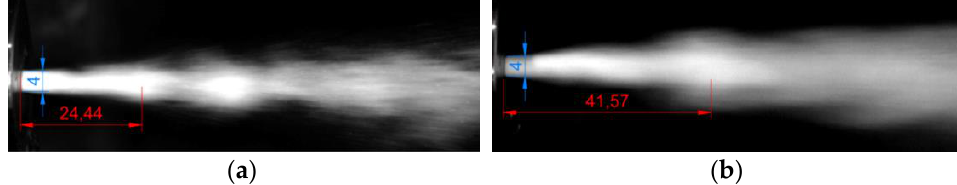
( b ) Figure 12. Images of the formation of hydrodynamic pulses during the operation of the head in